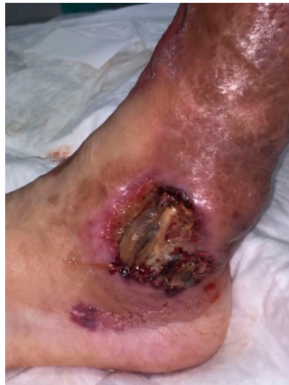
Figure 3. Skin ulcer on left ankle with violaceous elevated borders in a patient with a long history of pyoderma gangrenosum and IgA-kappa monoclonal gammopathy of undetermined